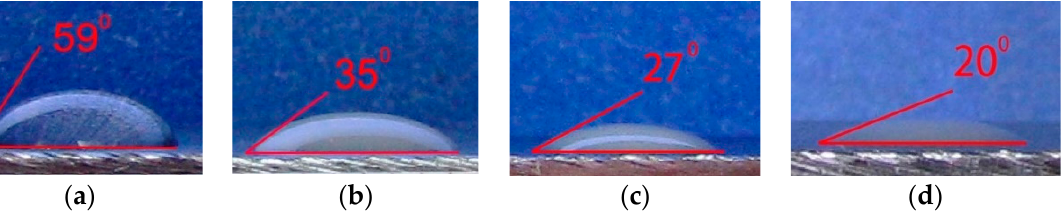
Figure 3. Wetting angles of water ( a ), LCL o ( b ), LCL r ( c ), and LCL s ( d ). The postoperative protective effect of LCL s , assessed by the appearance of the chips— the “indicator”—after 100 h (absence of traces of corrosion on the chip, Figure 4) following turning confirmed the reliability of its protective action [30,141,145].